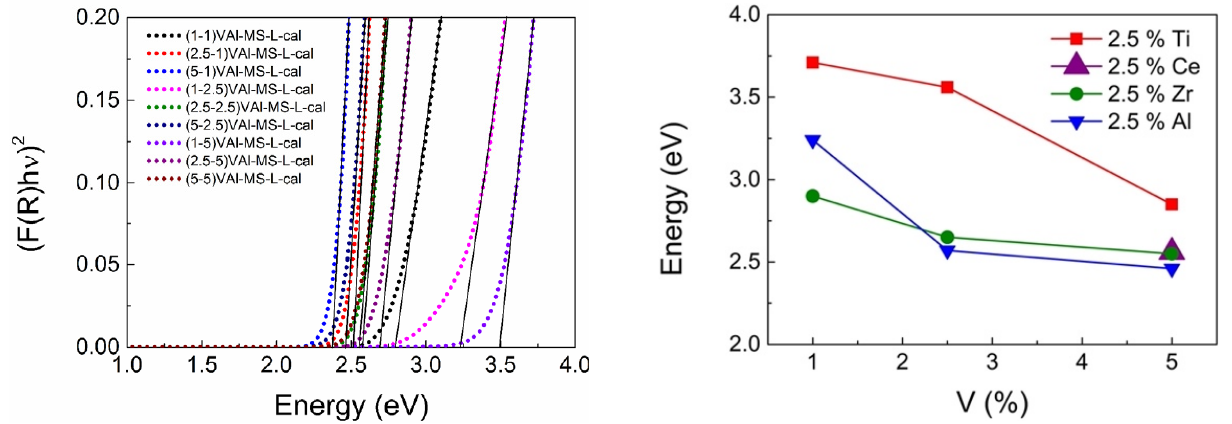
Figure 3. Tauc plots and determination of the optical gap, E g , by linear extrapolation ( left ) and, evolution of E g depending on the loading and nature of the anchors ( right ).